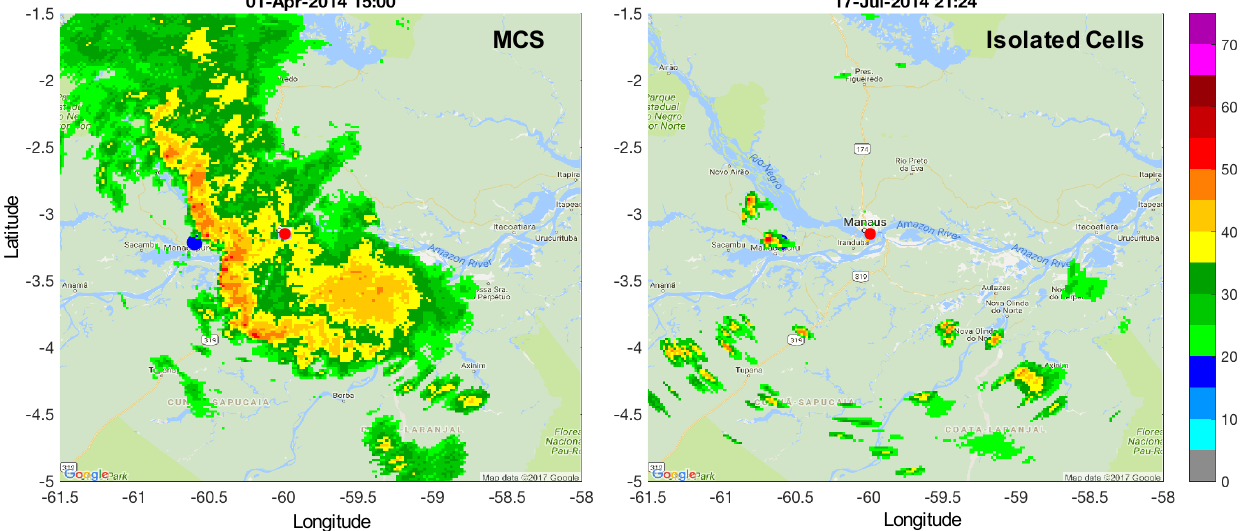
Figure 1. Reflectivity (dBZ) from S -band radar on 1 April 2014 at 15:00UTC (11:00LT) before the passage of an MCS, and at 17 July 2017 at 21:24UTC (17:24LT) after the passage of an isolated cell. The red dot indicates the location of the S -band radar, and the blue dot indicates the location of the main GoAmazon site